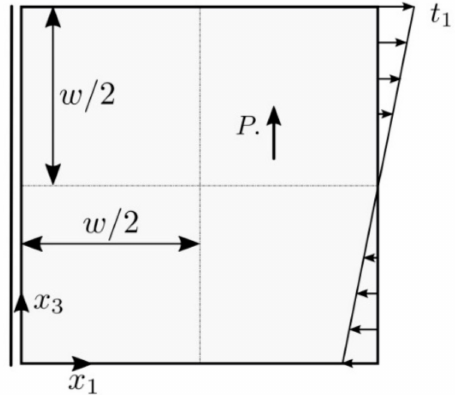
Figure 2. A square piezoelectric panel under bending.